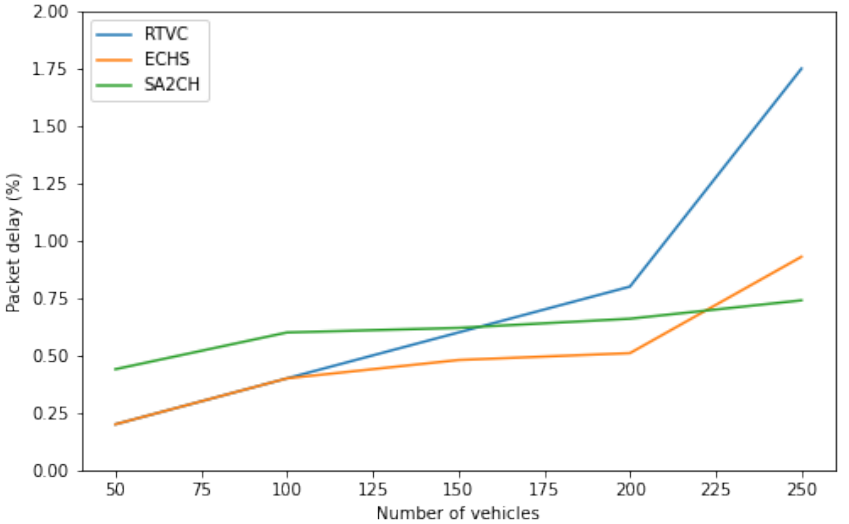
Figure 12. Comparative graph of APD between the existing and proposed